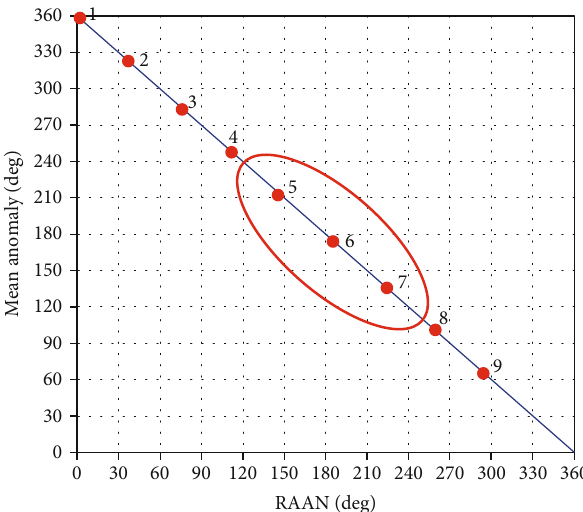
Figure 4: RAAN vs. mean anomaly of 9 satellite COF.